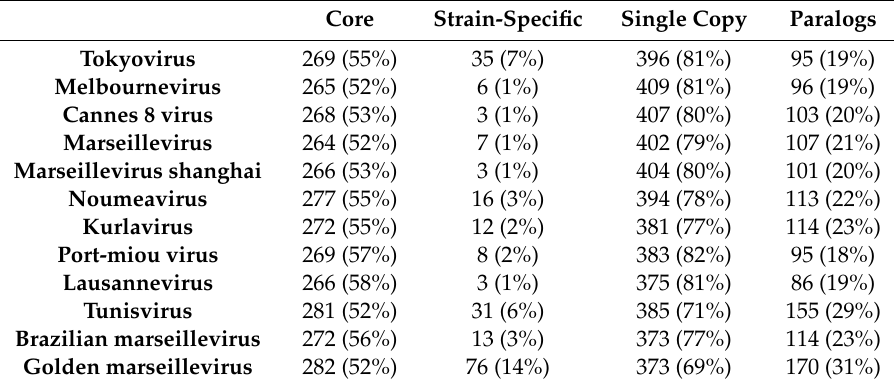
Counts and frequencies of core, strain-specific, single-copy and paralogous genes in